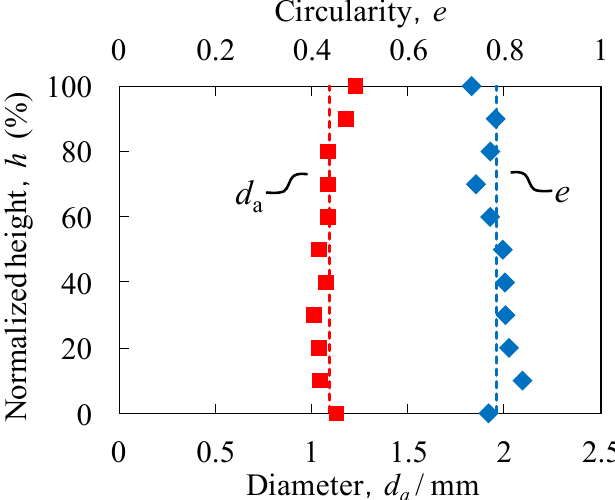
Figure 8. Relationship between specimen height and average diameter d a and circularity e of